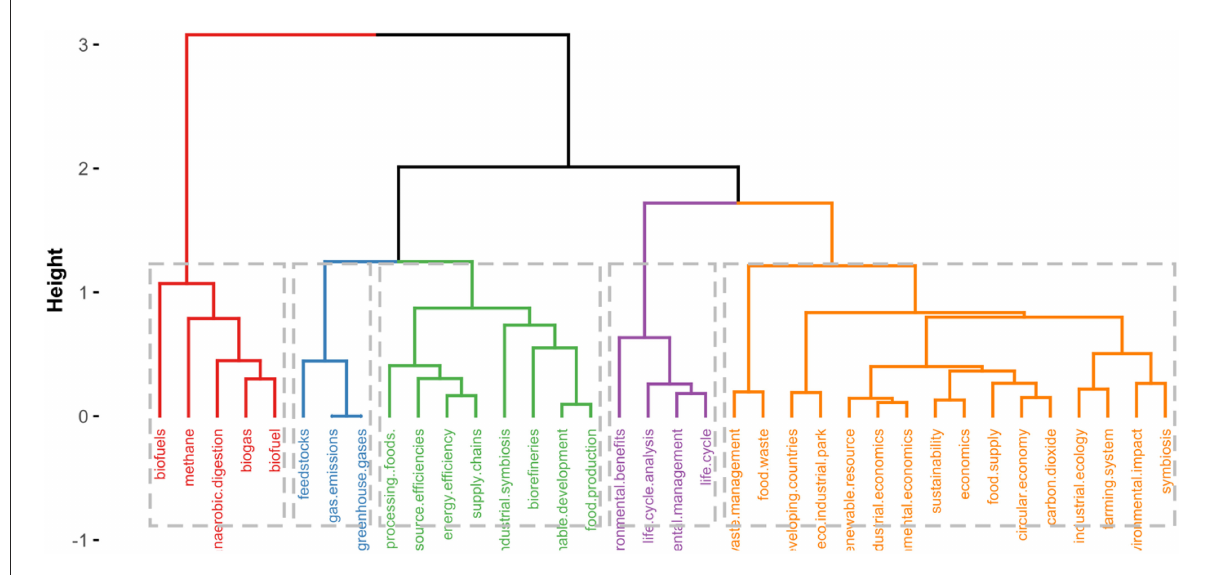
FIGURE7 Dendrogram of hierarchical link between clusters. Source: our elaboration using “bibliometrix” R package.